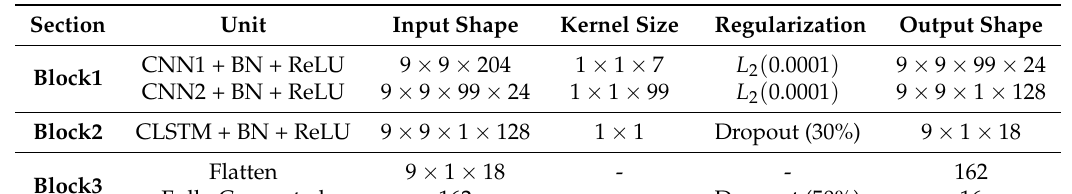
Figure 5. The patch-related convolutional long short-term memory (PRCLSTM) framework for the classification of Salinas dataset with a 9 × 9 × 204 window size for the input cube. Table 4. The configuration of the PRCLSTM for the classification of the Salinas dataset with a 9 × 9 × 204 window size for the input cube.